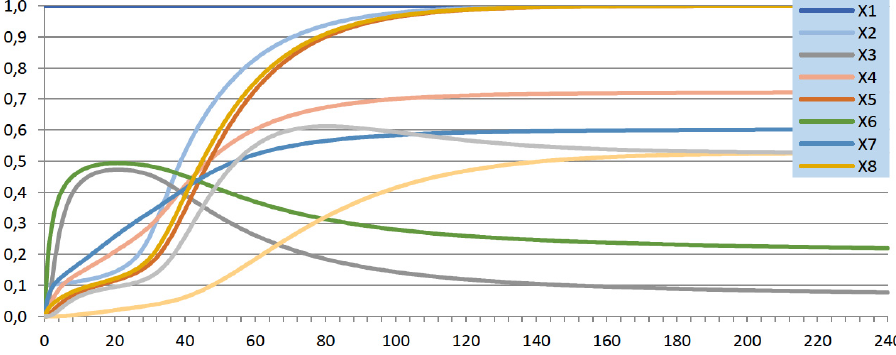
Fig. 2. Simulation results of working under an extremely stressful condition (Scenario 1):